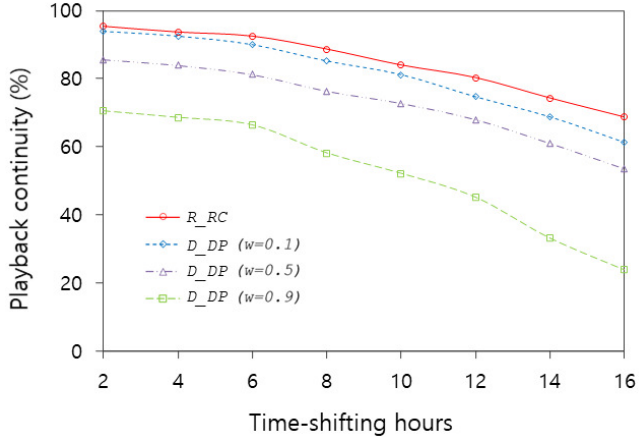
Figure 10. Comparison of playback requests between D _ DP and R _ RP in distribution 3 with a 150 s buffer.